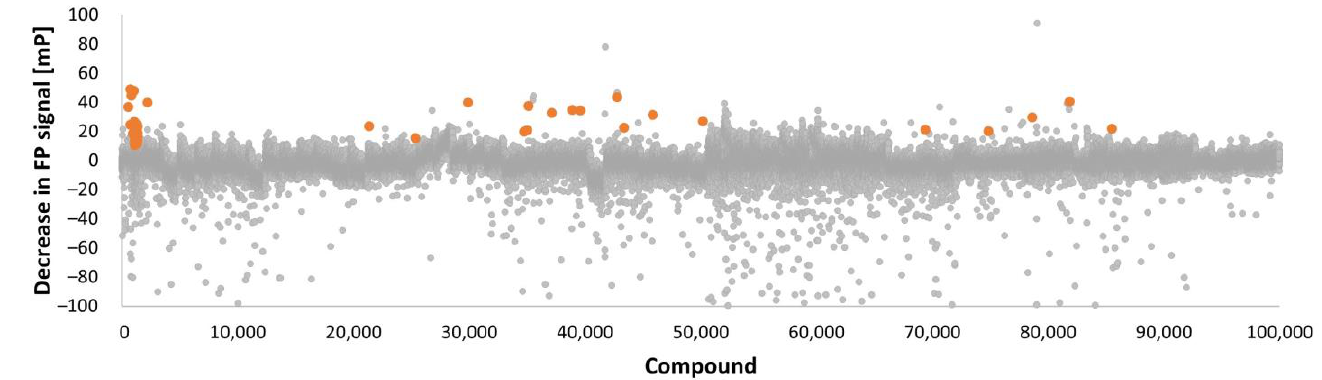
Figure 1. Fluorescence polarization signal in screening. Data presented is decrease in FP [mP] for each 103,400 compounds screened. Verified 51 hits are marked with orange color.